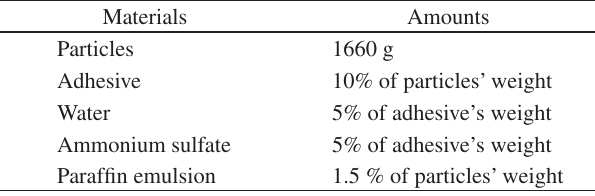
Table 1. Quantity of materials for the manufacture of the particleboards. Materials Amounts Particles 1660 g